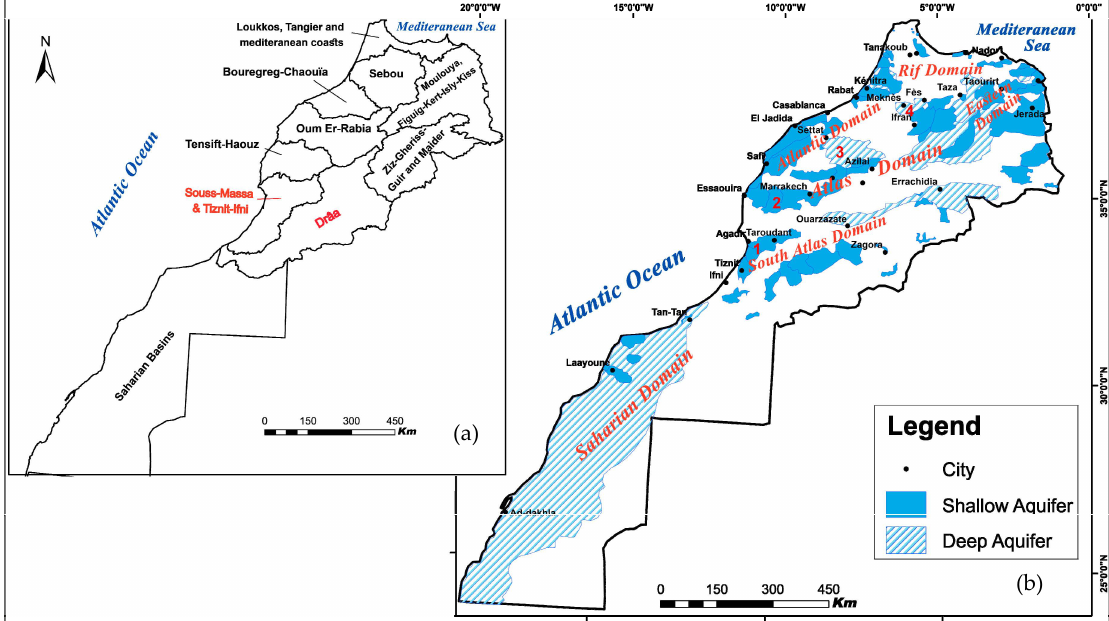
Figure 2. ( a ) Main basins in Morocco. ( b ) Main aquifers (red digits indicate the locations of major exploited aquifers: 1: Souss-Massa, 2: Haouz, 3: Tadla 4: Saïs), modified after [9]. The two studied basins and six hydrogeological domains are indicated by red text in (a) and (b), respectively.